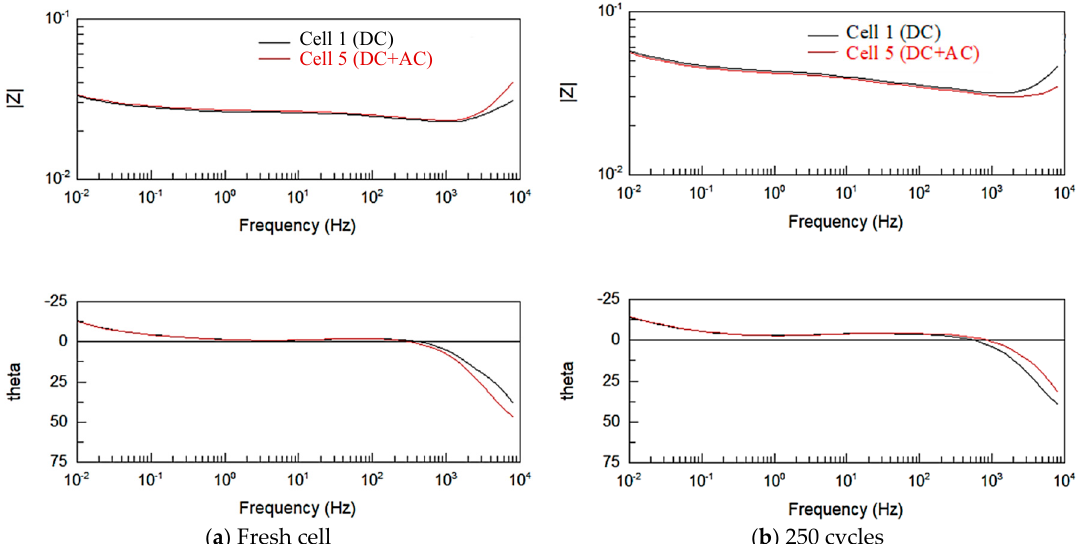
Figure 10. Bode plot shows impedance vs. frequency and phase vs. frequency for cells 1 ( black ) and 5 ( red ) at 80% SOC, for ( a ) fresh cells, and ( b ) after 250 cycles were performed.